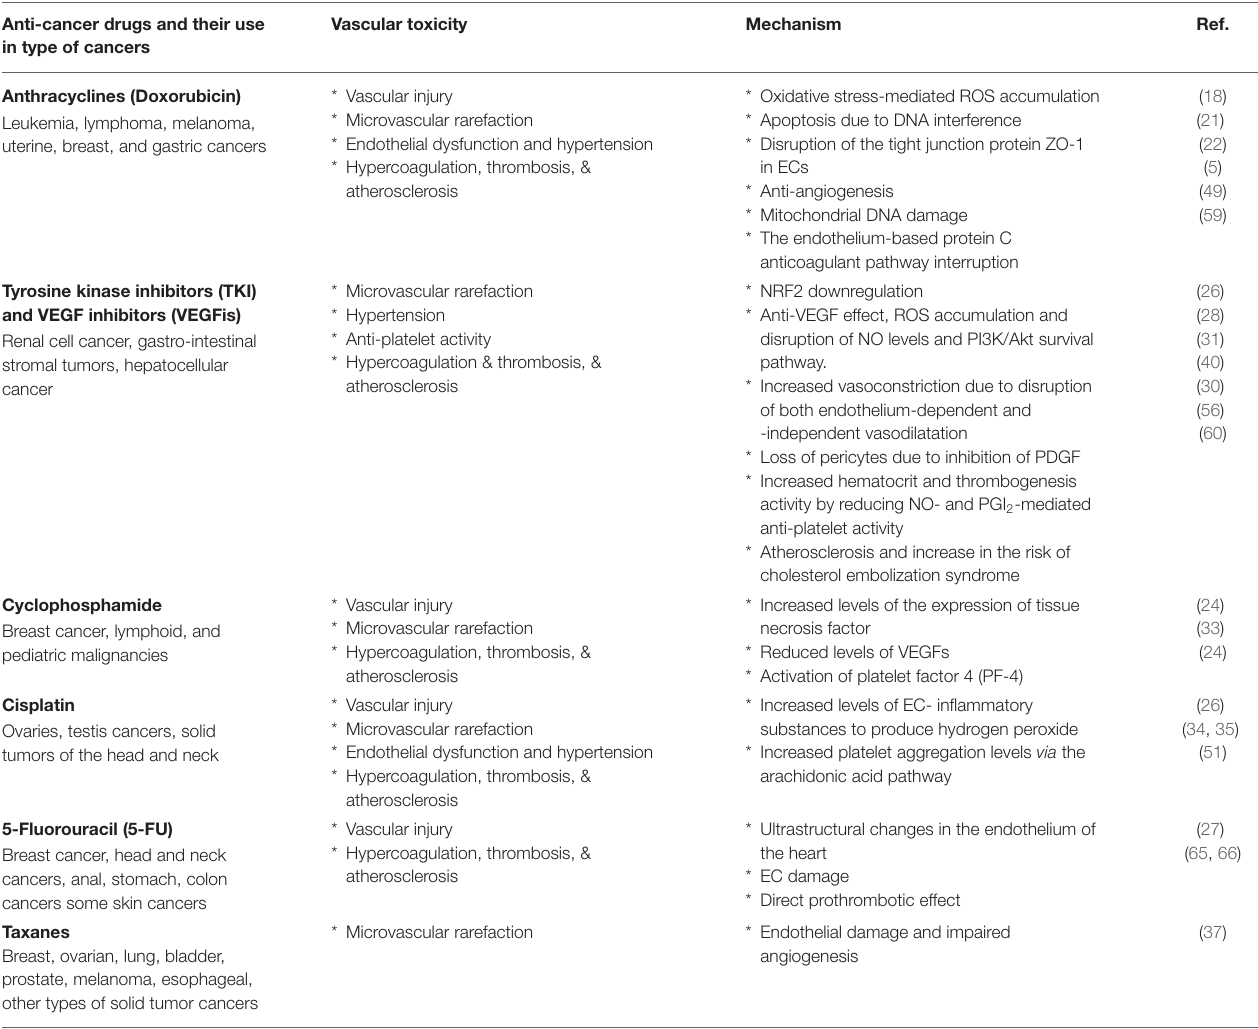
TABLE 1 | Vascular damages and diseases induced by the widely prescribed anticancer